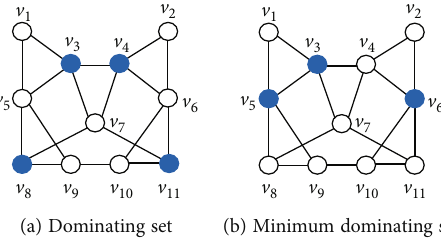
Figure 6: Dominant set